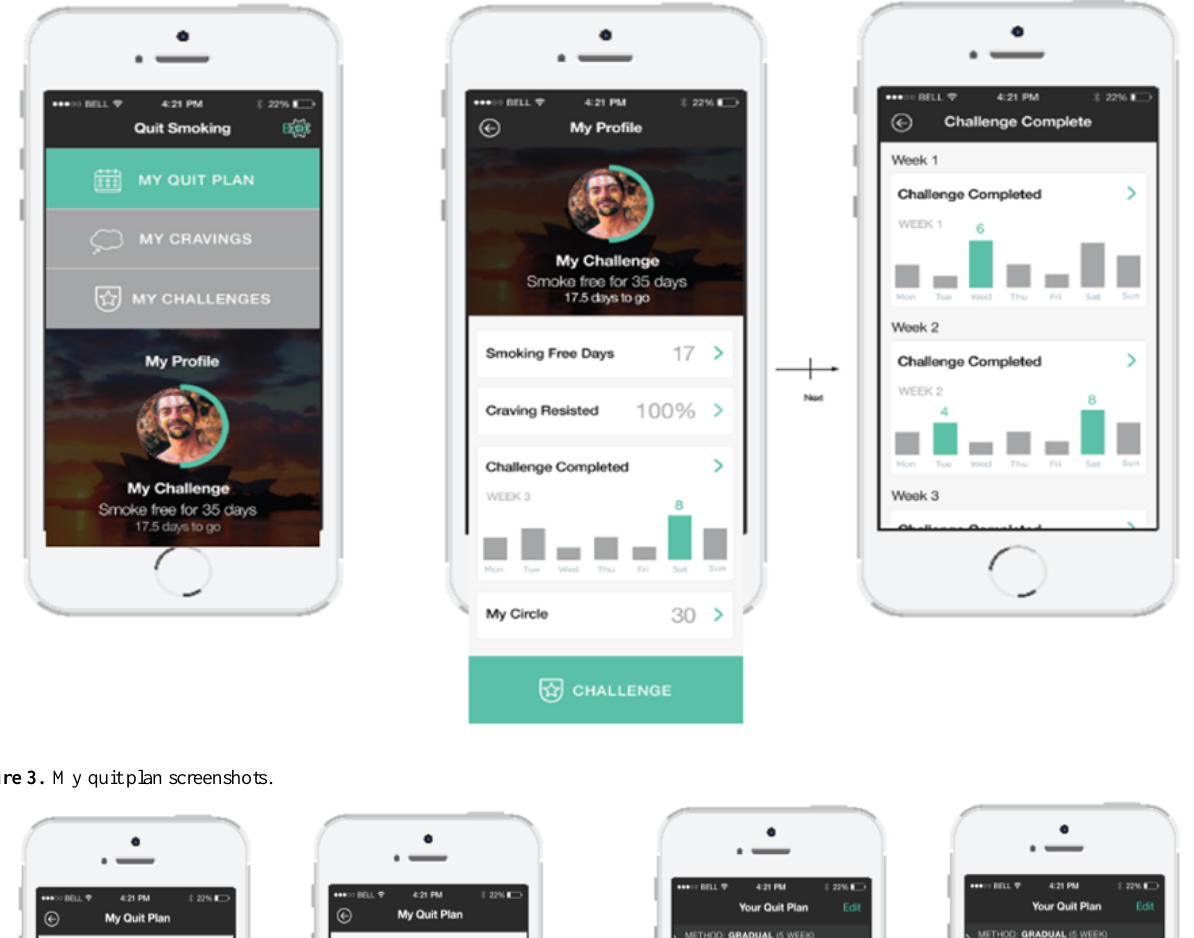
Figure 2. The challenge function screenshots.